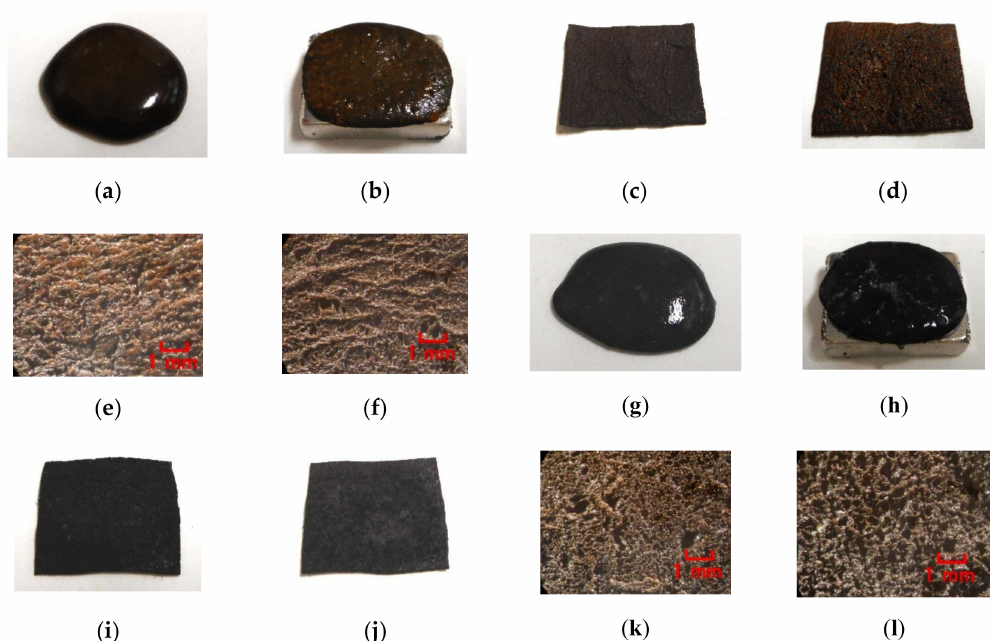
Figure 12. Images of liquid before electrolytic polymerization and electrolytically polymerized rubber mixed with KF96, W40, water-insoluble MF: ( a – f ) MSGS60; ( g – l ) A500; ( a , g ) liquid before electrolytic polymerization without magnetic field; ( b , h ) liquid before electrolytic polymerization under magnetic field; ( c , i ) panoramic image of electrolytically polymerized rubber facing anode; ( d , j ) panoramic image of electrolytically polymerized rubber facing cathode; ( e , k ) microscopic image of electrolytically polymerized rubber facing anode by optical microscope; ( f , l ) microscopic image of electrolytically polymerized rubber facing cathode by optical